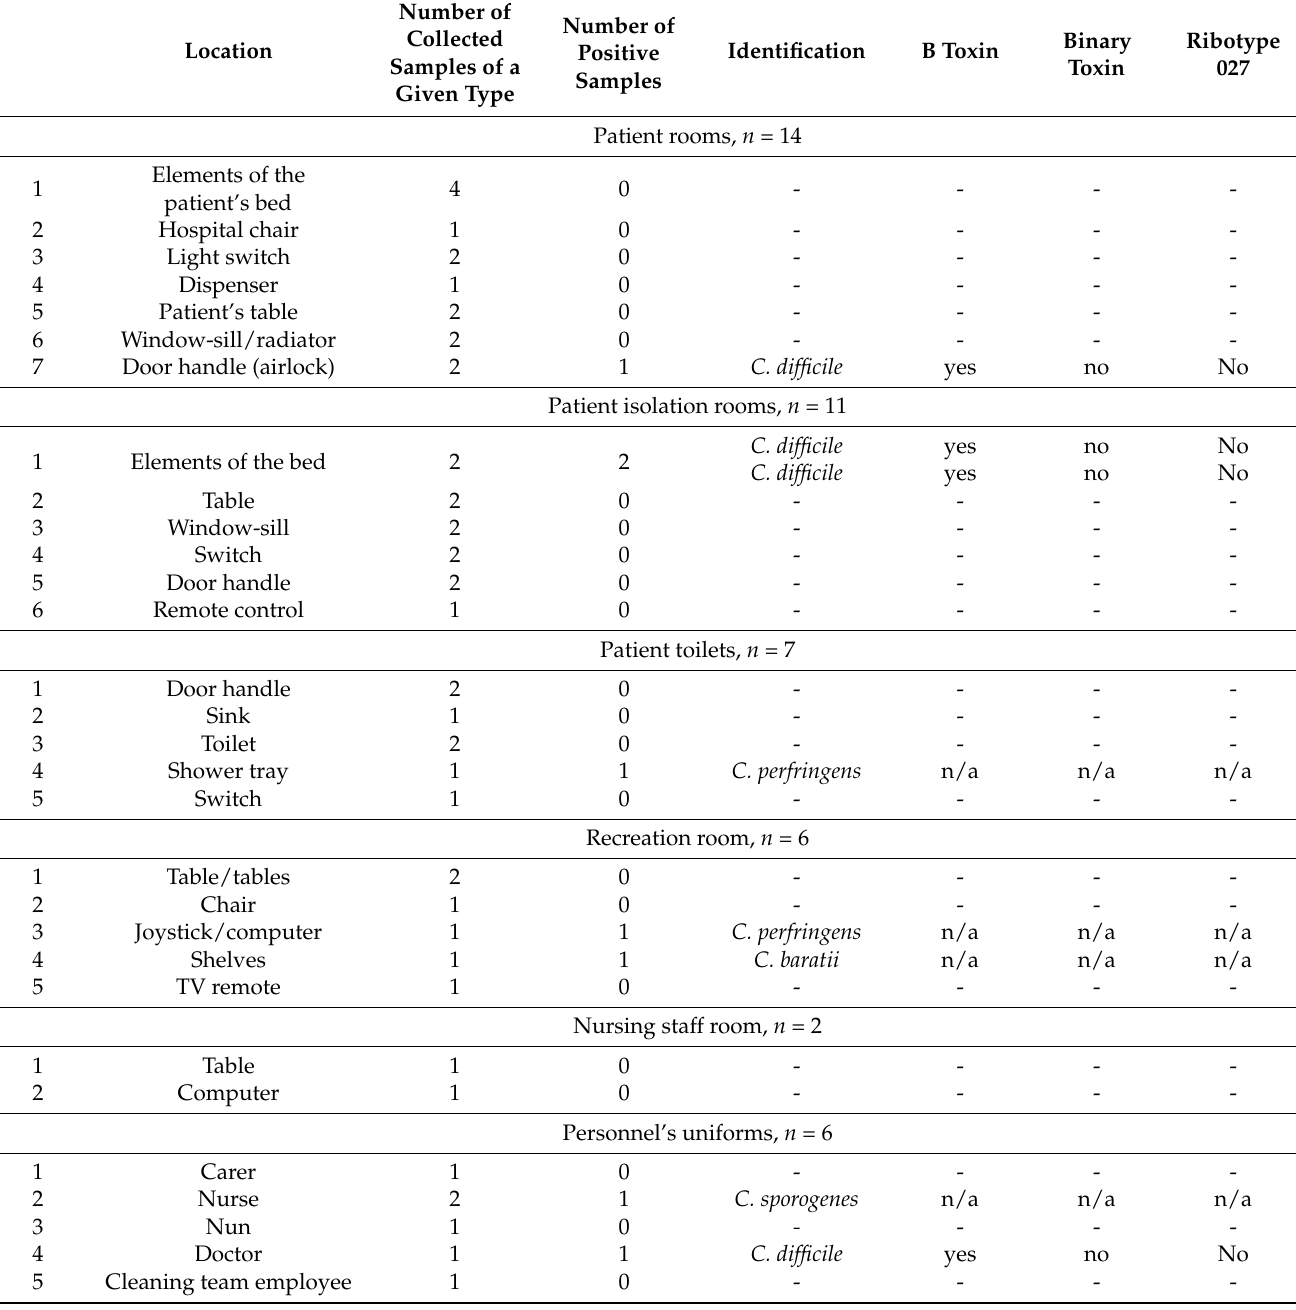
Table 3. Results of the microbiological testing conducted at the Oncology Unit ( n = 46 total